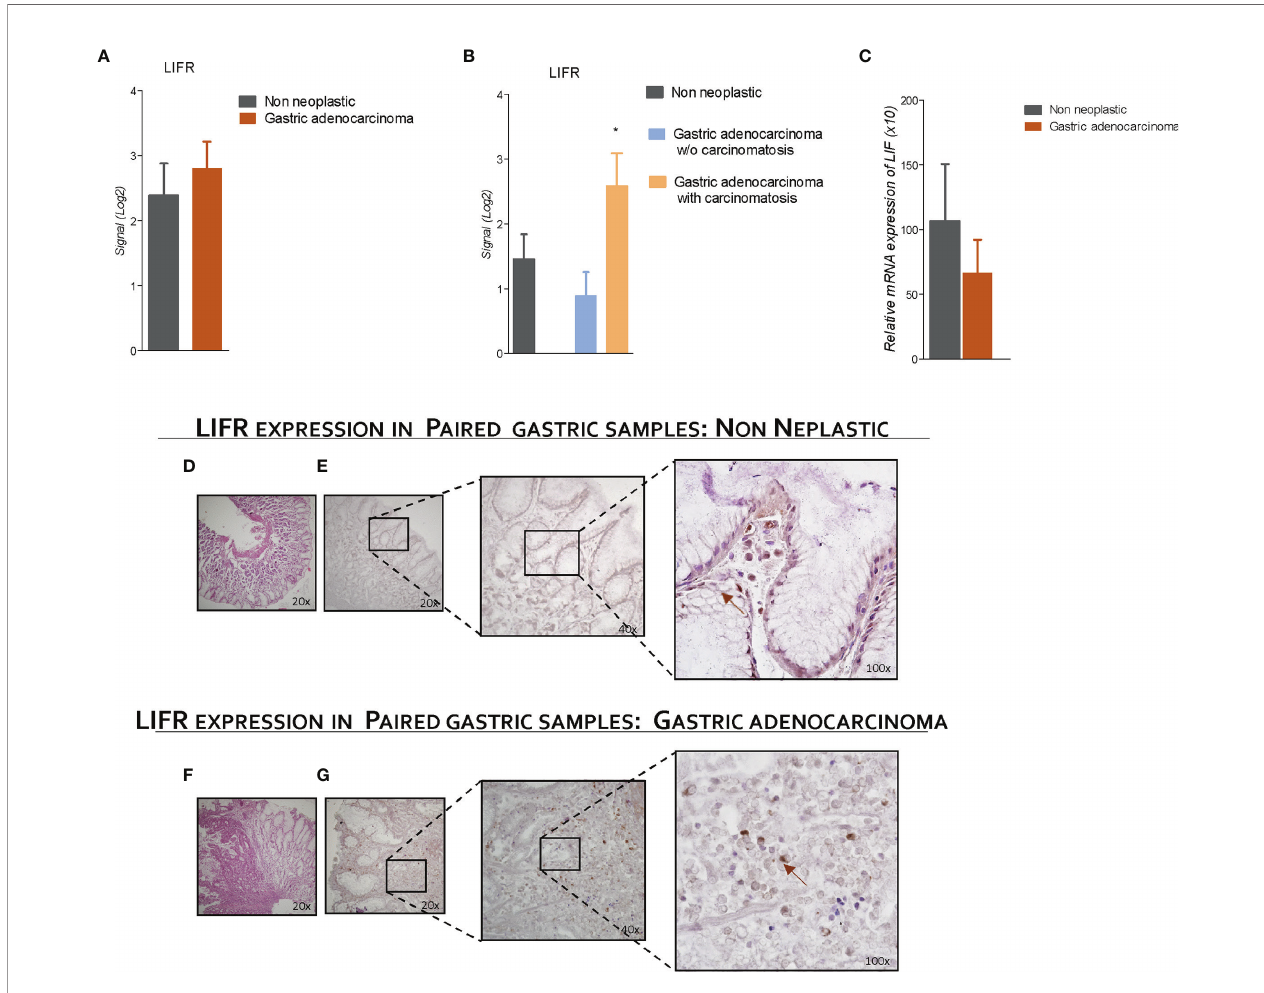
FIGURE 4 | LIFR is a negative prognostic factor for survival of a patient with GC with carcinomatosis. The expression of LIFR and LIF was examined in surgical samples from non-neoplastic and gastric adenocarcinoma mucosa obtained by patients with GC underwent surgery for GC treatment. Data shown are follows: Gene expression of LIFR (Log2) (A) in non-neoplastic vs. neoplastic mucosa and (B) in non-neoplastic and gastric adenocarcinoma w/o carcinomatosis vs. adenocarcinoma with carcinomatosis. (C) Relative mRNA expression of LIF. (D) H&E staining of non-neoplastic mucosa (magni fi cation, ×20). (E) IHC staining of non-neoplastic mucosa (magni fi cation, ×20, ×40, and ×100). (F) (hematoxylin and eosin) H&E staining of gastric adenocarcinoma mucosa (magni fi cation, ×20). (G) IHC staining of IHC staining of gastric adenocarcinoma mucosa (magni fi cation, ×20, ×40, and ×100). * represents statistical signi fi cance versus Non neoplastic